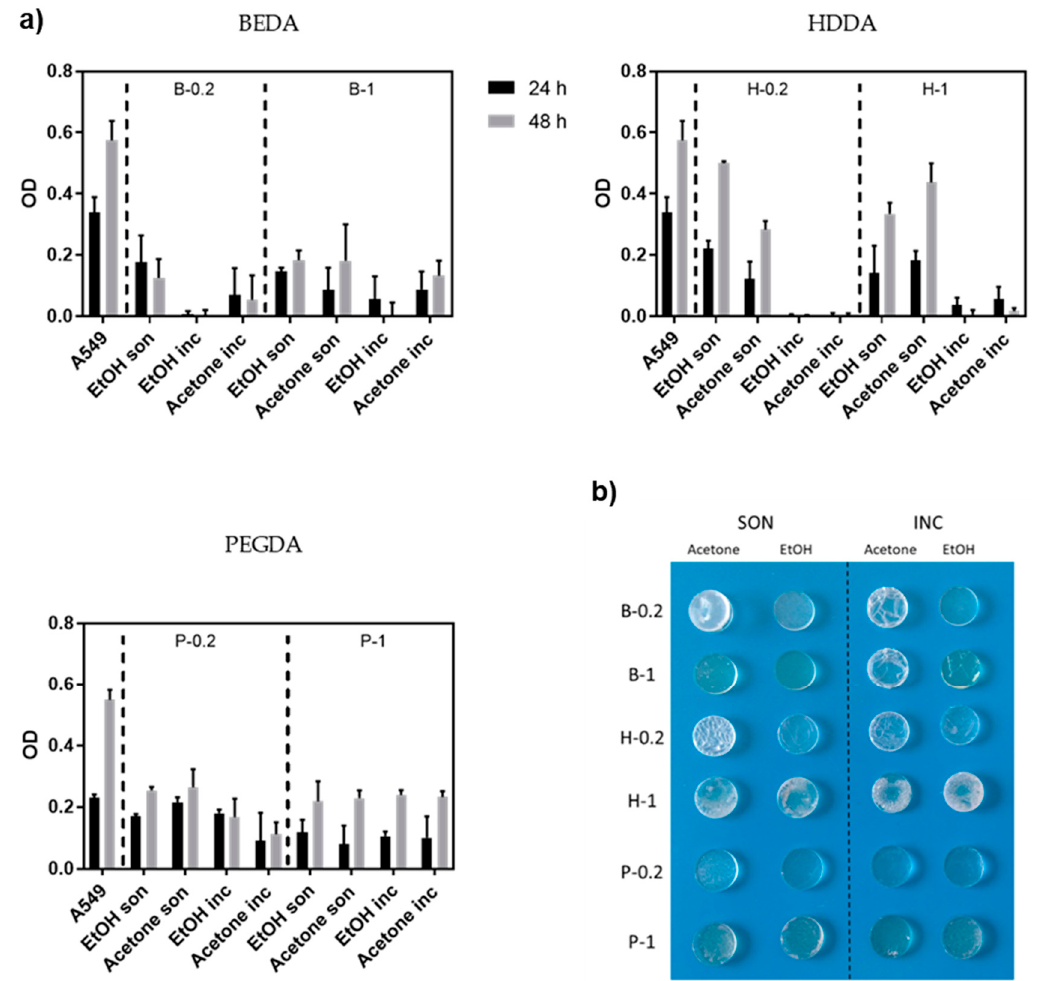
Figure 3. ( a ) Measurement of growth (MTT assay) of A549 cells seeded on three di ff erent resins (BEDA, HDDA, and PEGDA) each with two di ff erent amount of photoinitiator (0.2 wt.% and 1 wt.%, respectively) and four di ff erent washing protocols (i.e., ethanol sonicated, acetone sonicated, ethanol incubated, and acetone incubated), as previously described. The viability is measured after 24 and 48 h. Error bars show mean SD. ( b ) Photograph showing the optical and mechanical properties of 3D printed disks made of the same three resins and four washing protocols evaluated by MTT